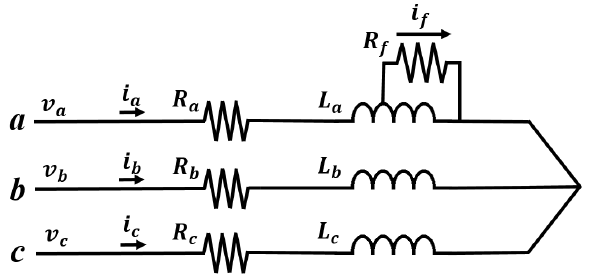
Figure 1. Equivalent model of a PMSM with an ITSF in the phase a